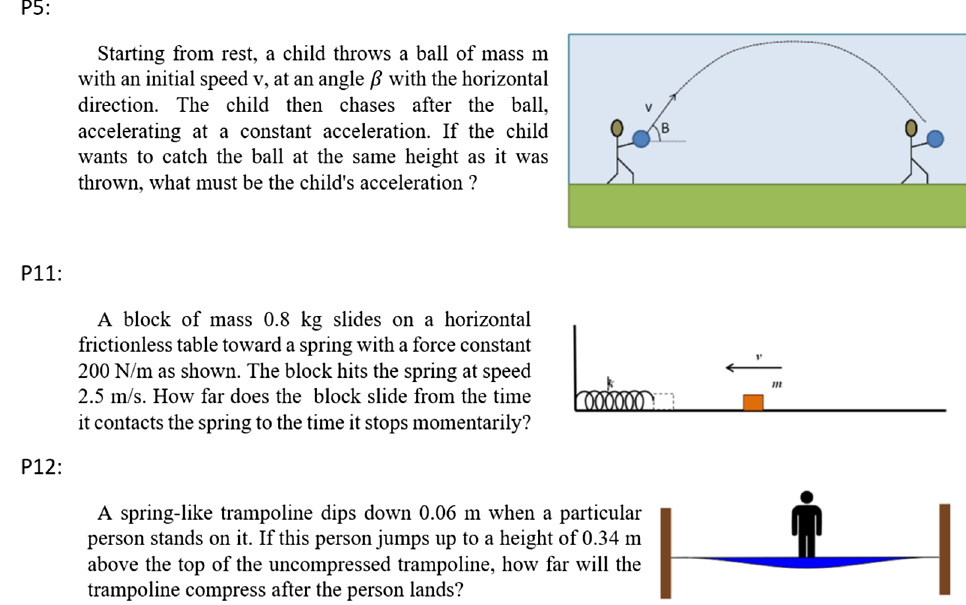
FIG. 11. Diagram and problem text for problems P5, P11, and